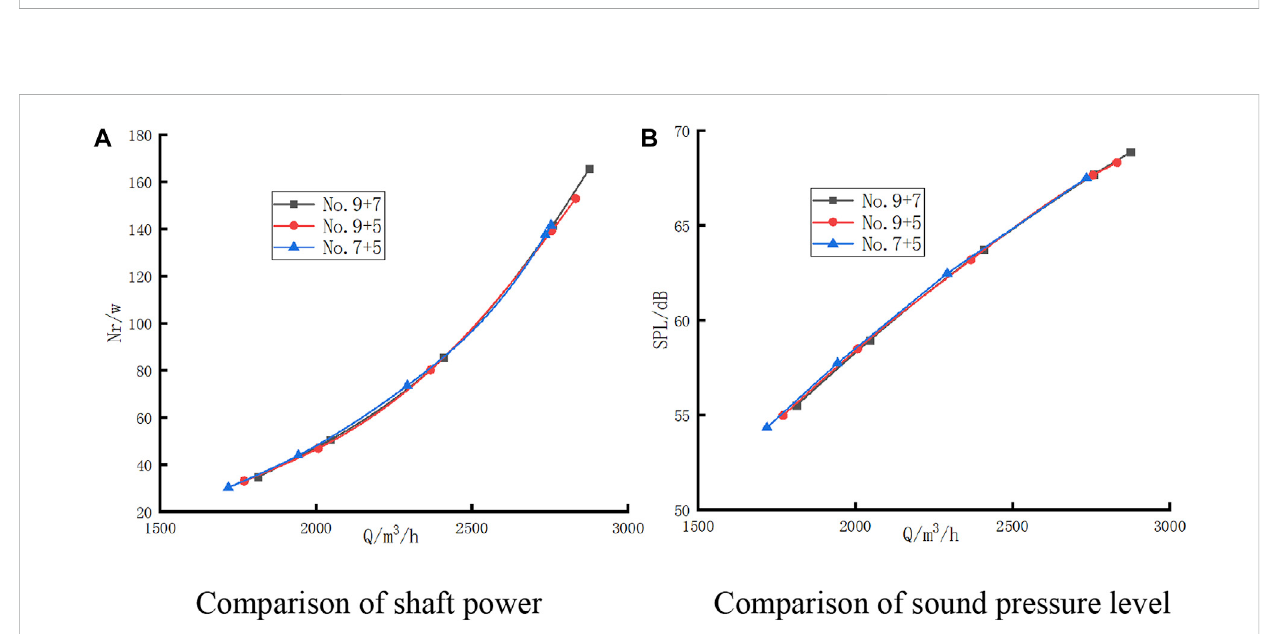
FIGURE 10 Variable rotational speed regulation characteristics of the fan with different blade number combinations: (A) comparison of shaft power; (B) comparison of SPL.